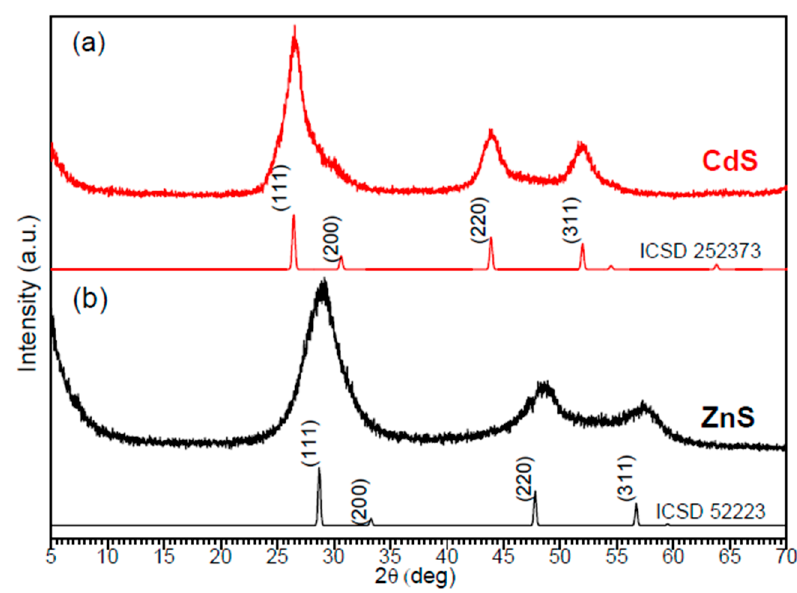
Figure 1. XRD diffraction patterns of ( a ) as-prepared CdS and simulated XRD pattern of cubic CdS (ICSD 252373); and ( b ) as-prepared ZnS and simulated XRD pattern of cubic ZnS (ICSD 52223).